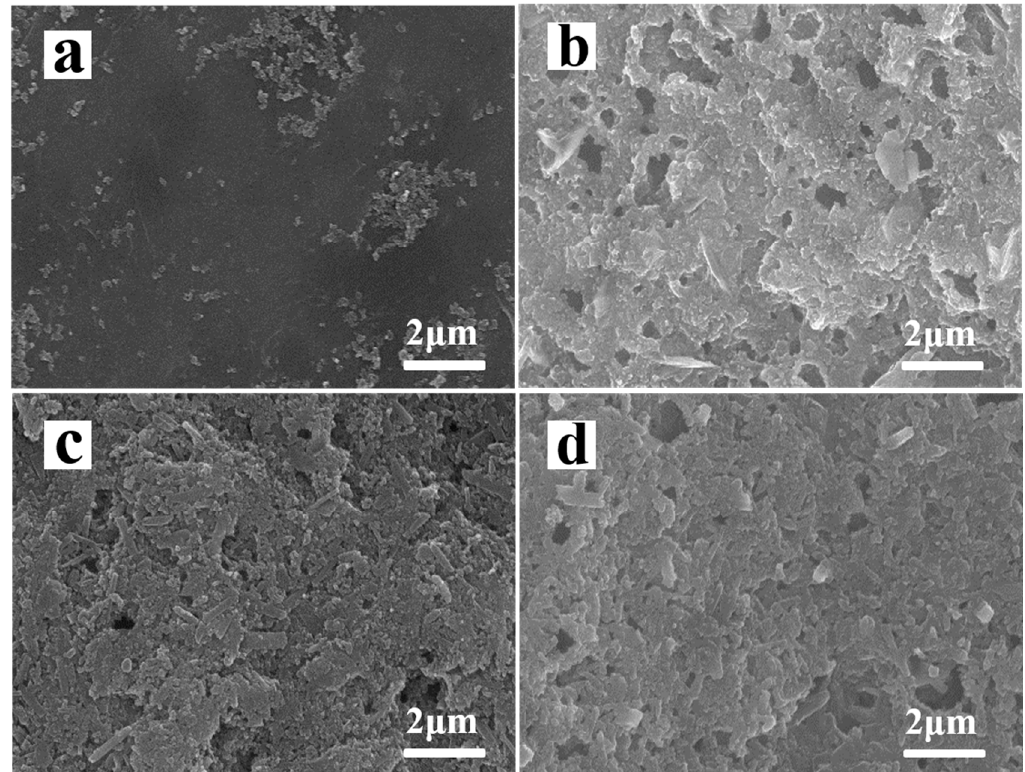
Figure 7. SEM morphologies of cathode: normal sulfur cathode ( a ) before cycling and ( b ) after 50 cycles; HNTs-80/S cathode ( c ) before cycling and ( d ) after 50 cycles.